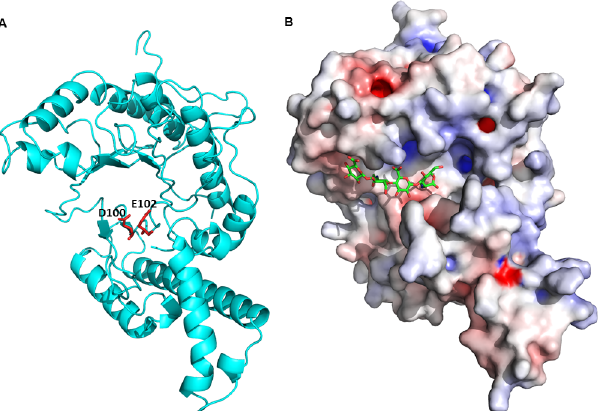
Fig 2. Three-dimensional modeling of LuloHya. Predicted 3D model of LuloHya was generated automatically by I-TASSER software. LuloHya coordinates used to generate the model were based on the ligand-free honeybee venom hyaluronidase (1FCQ) and in complex (1FCV) with hyaluronic acid tetramer. (A) Cartoon generated with PyMol shows LuloHya as a typical globular protein with a catalytic site topology of the cleft/groove class. Conserved amino acid residues aspartic acid (D100) and glutamic acid (E102) are highlighted in red. (B) Electrostatic potential of LuloHya generated by the APBS tools shows charged amino acids evenly distributed on the surface of the enzyme as determined by the Adaptive Poisson-Bolzmann Solver software with blue being positive and red being negative. Predicted substrate (HA tetramer) bound to LuloHya catalytic cleft if shown.